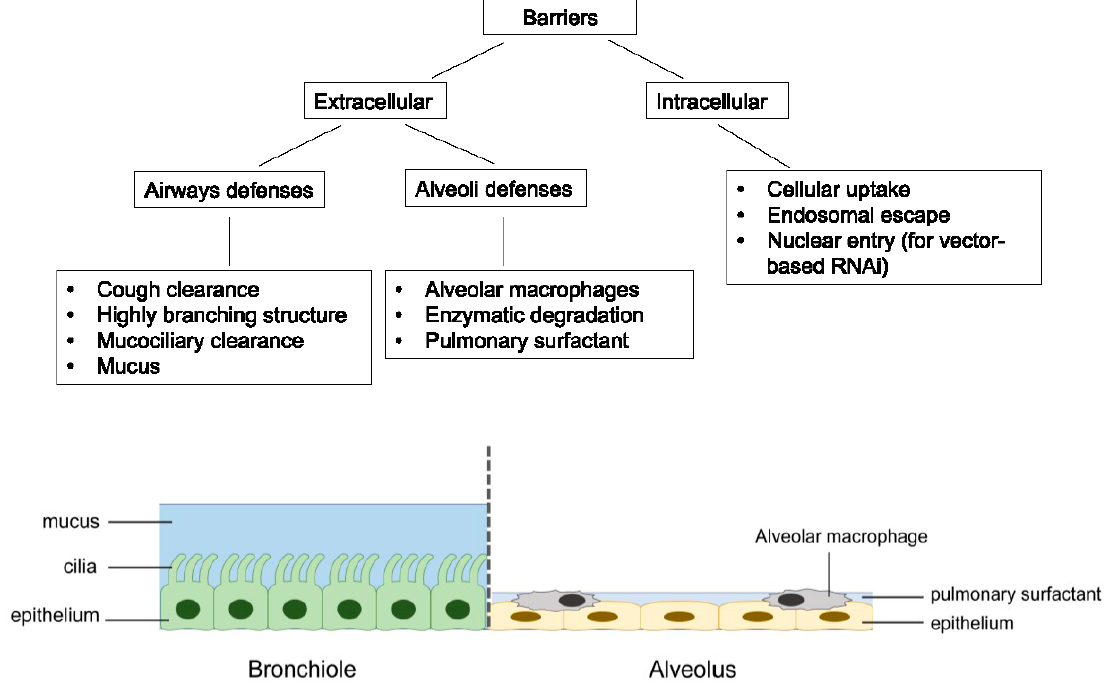
Figure 2. Summary of the major barriers associated with pulmonary delivery of RNAi molecules.